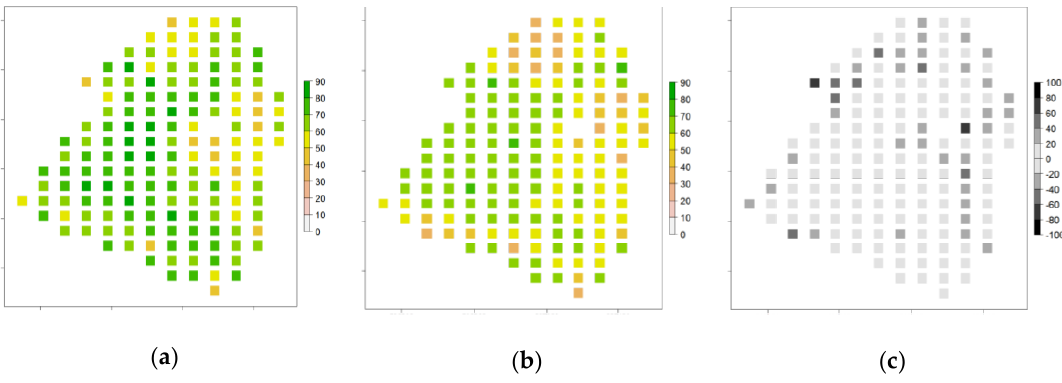
Figure 5. Maps of wheat yield (expressed in q.ha −1 ) collected on a plot dedicated to the cultivation of wheat in 2015 ( a ) and in 2017 ( b ), together with the differences between the relative values of yields (expressed in percent) ( c ).